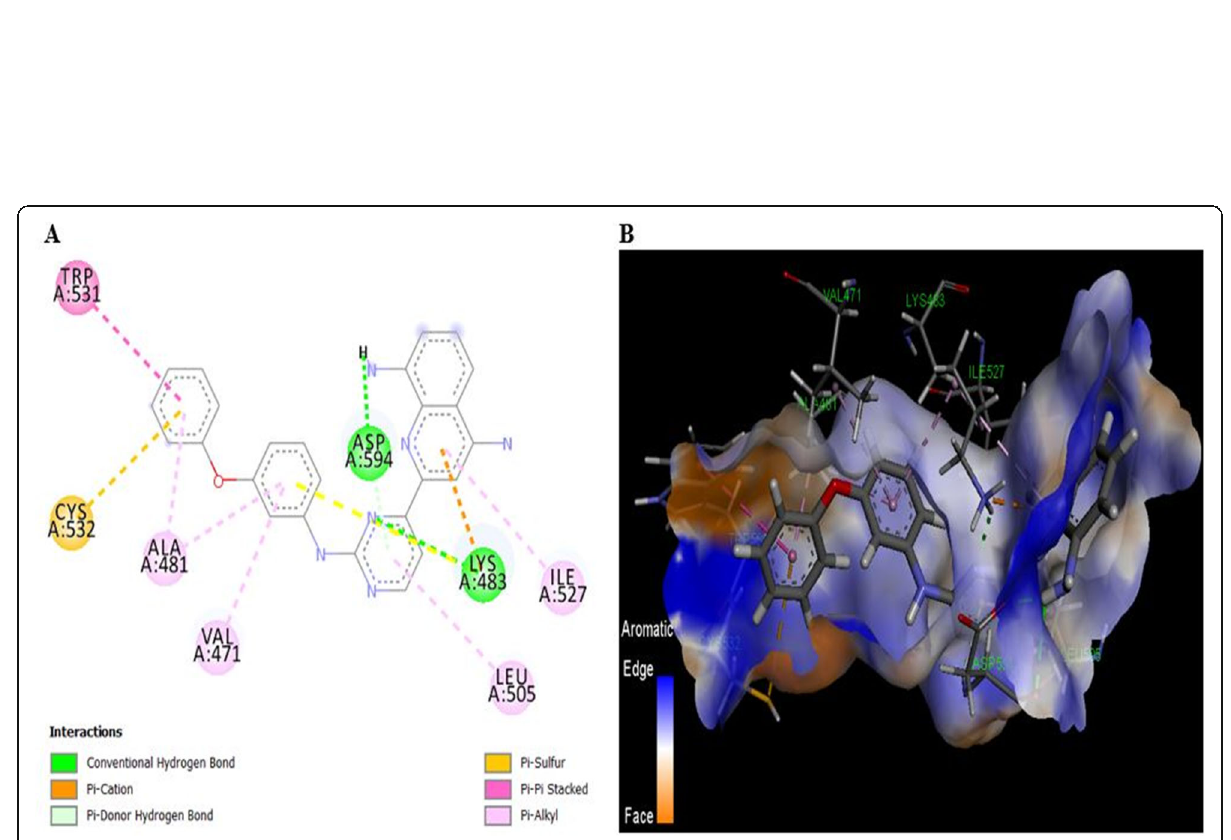
Fig. 5 a 2D diagram for the interaction of compound 11 with V600E-BRAF. b 3D diagram of compound 11 in the binding site of